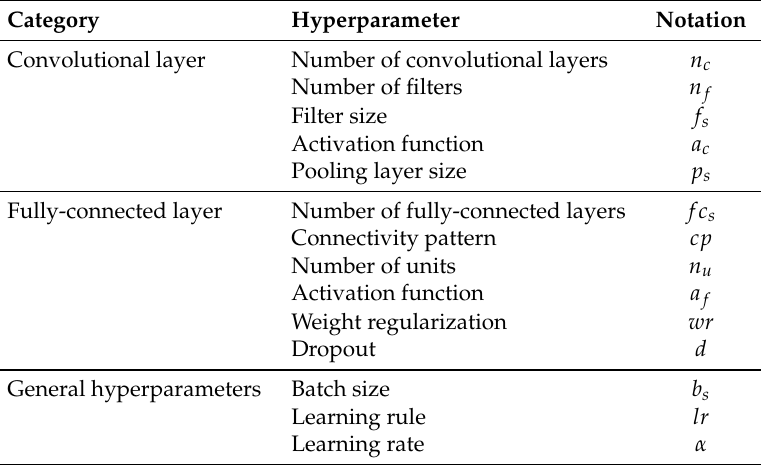
Table 6. Convolutional neural network